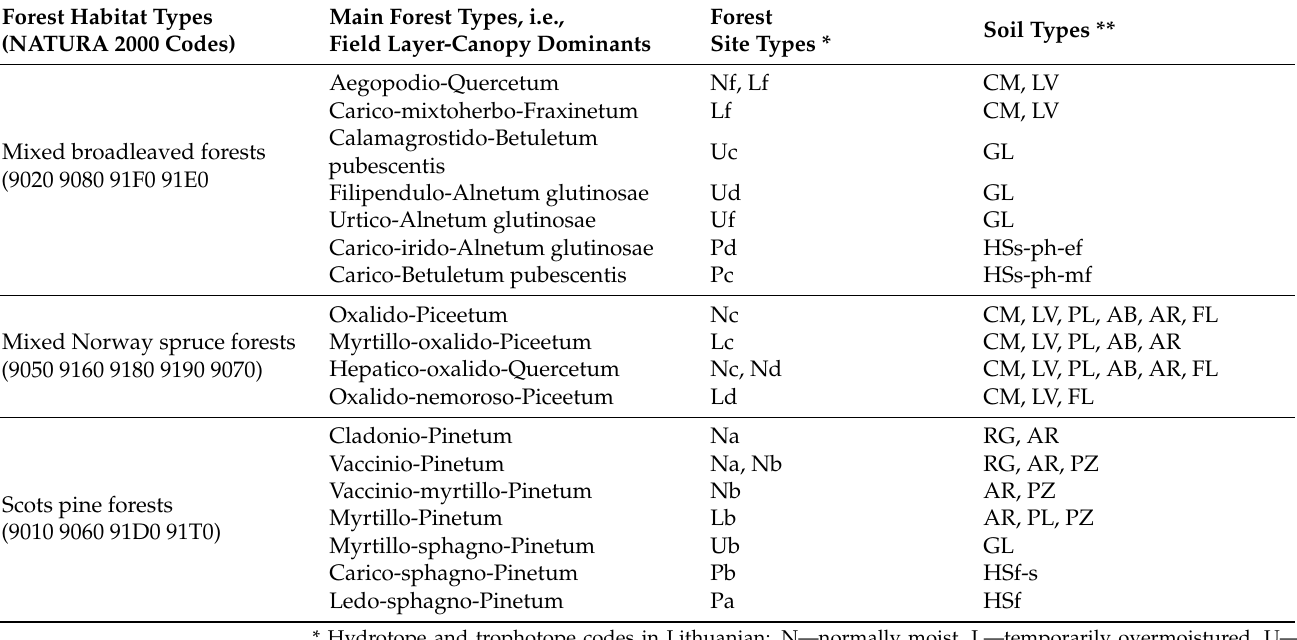
Table 1. Ecological features of hemiboreal forest in